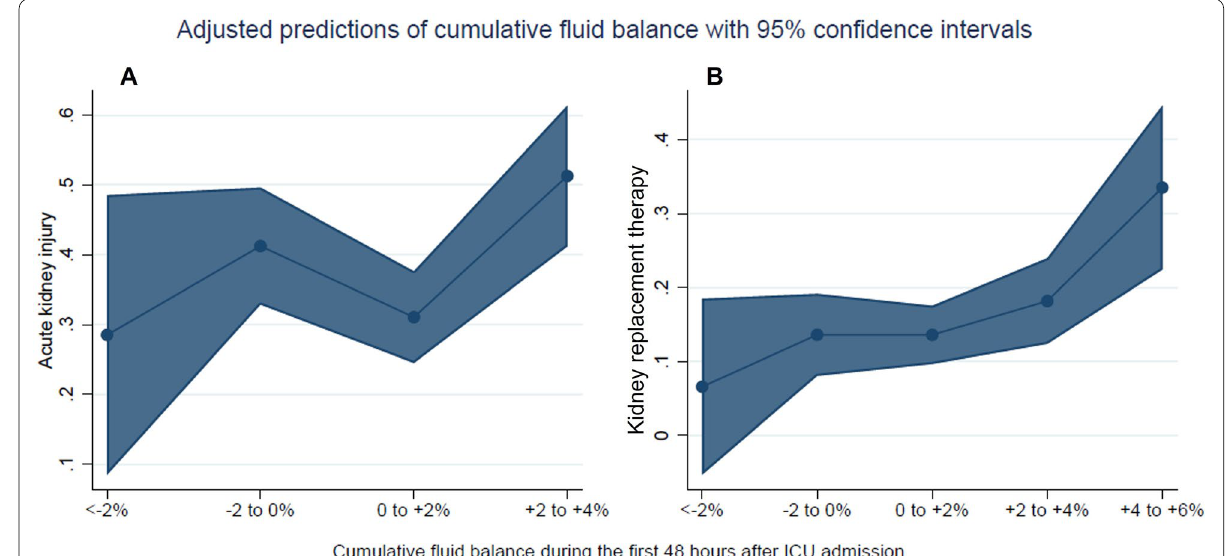
Fig. 4 Adjusted risks of developing new-onset AKI ( A ) and KRT ( B ) after 48 h by percentage of 48-h cumulative fluid balance (%). AKI acute kidney injury, KRT kidney replacement